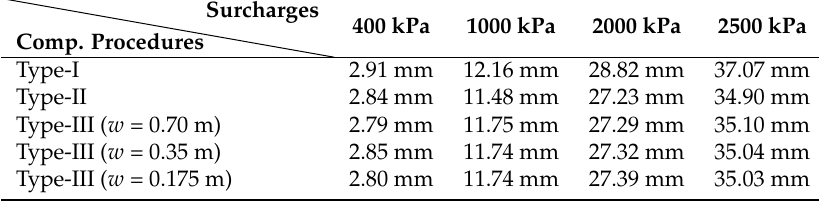
Table 4. Maximum lateral displacement induced during serviceability stage by various